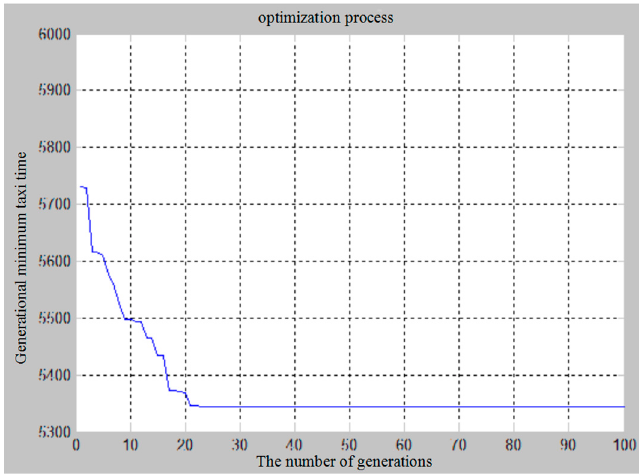
Figure 7. The minimum taxiing time curve generated using the genetic algorithm.